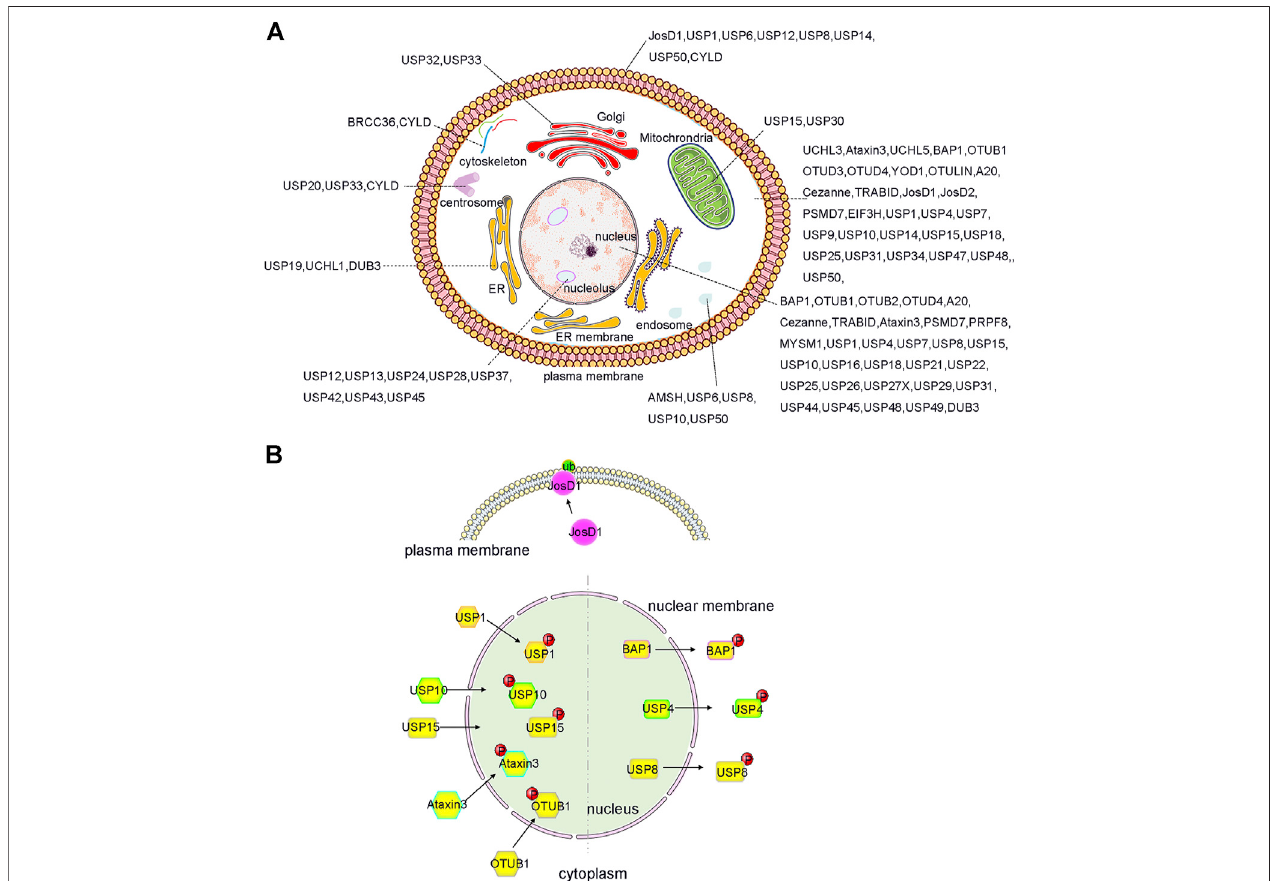
FIGURE2| LocalizationandPTMsinducedtranslocationofDUBs. (A) DUBshavebeenreportedtolocalizeandfunctioninalmosteveryintracellularcompartment, such as nucleolus, cell membrane and mitochrondria etc., and have speci fi c roles. Importantly, the function of DUB can be expanded by ensuring that a single DUB localizes to distinct organelles as shown, for example, for JosD1, USP4 and USP25 etc. (B) PTMs, such as phosphorylation and ubiquitination, play an important role in regulation the alternative localization of DUB. For example, phosphorylation of BAP1, USP4 and USP8 causes them to relocate from the nucleus to the cytosol. In contrast,phosphorylationofOTUB1,Ataxin3,USP15,USP10,andUSP1triggersitstranslocationfromcytosoltothenucleus.Additionally,ubiquitinationofJosD1leads its translocation from cytosol to cell membrane. The fi gure was generated based on the reported